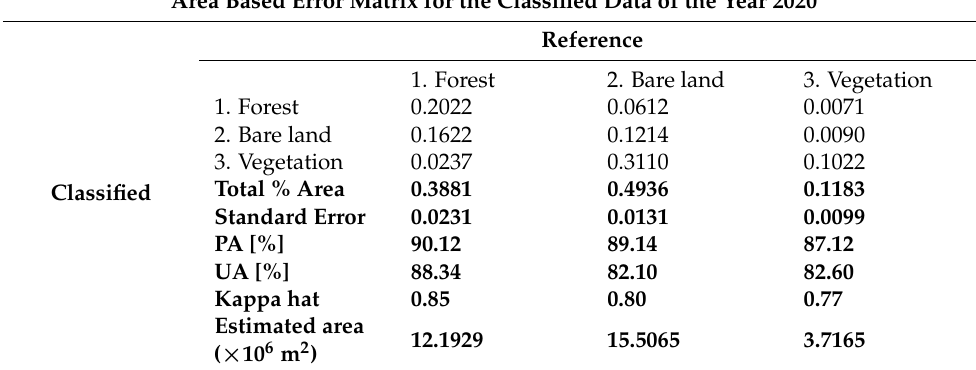
Table 10. Accuracy assessment parameters for the classified data of the year